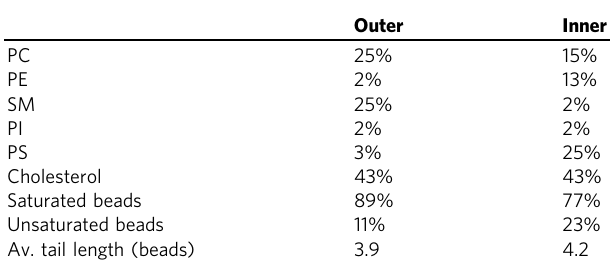
Table 1 Summary of lipid composition and properties in models for the outer and inner lea fl